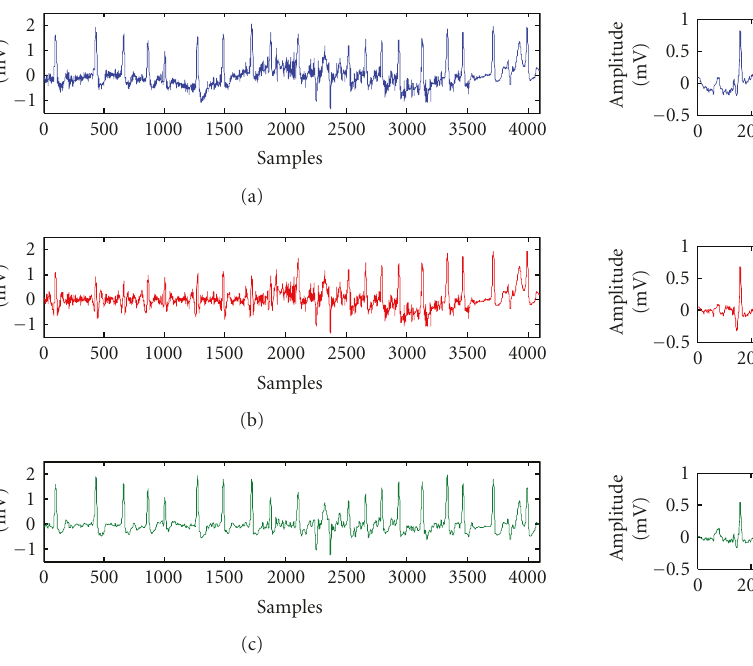
Figure 9: Typical results of di ff erent methods for baseline correc- tion in presence of DC components and lowpass interference. (a) MIT-BIH record 203, (b) result of applying WT, (c) result of apply- ing MABWT.